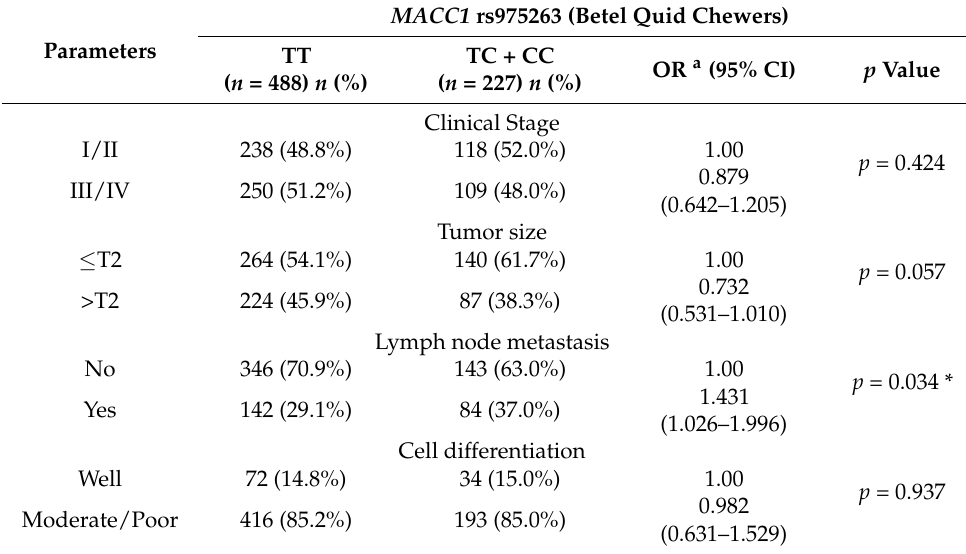
Table 5. The effect of MACC1 SNPs genotype frequencies of 715 oral cancer patients who chewed betel quid on the clinicopathological parameters.